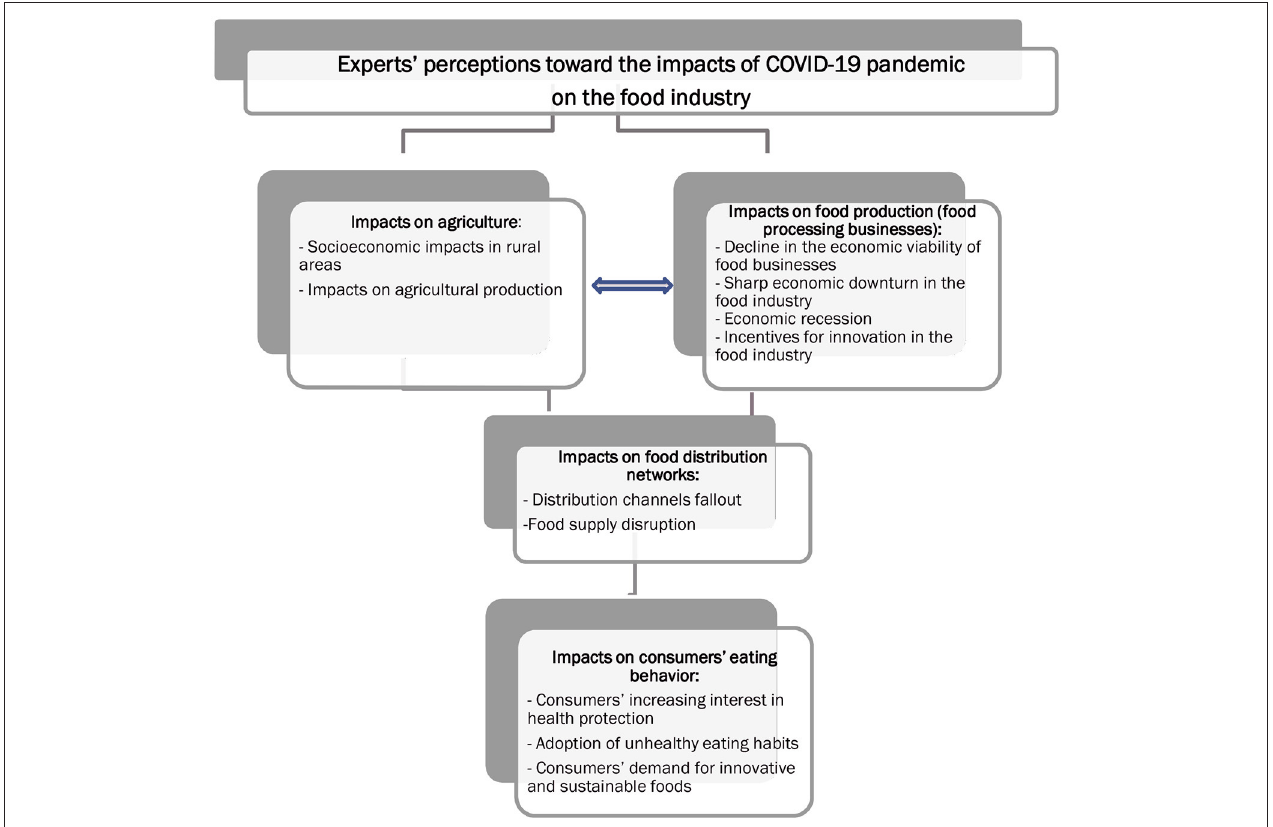
FIGURE 1 | Experts’ perceptions toward the impacts of COVID-19 pandemic on the various facets of the food